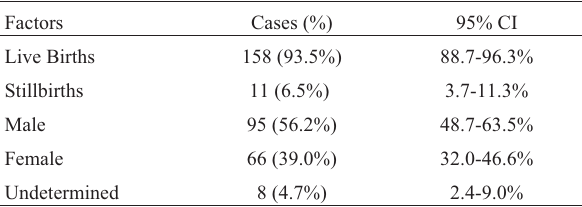
Table 1 - Characteristics of subjects with birth